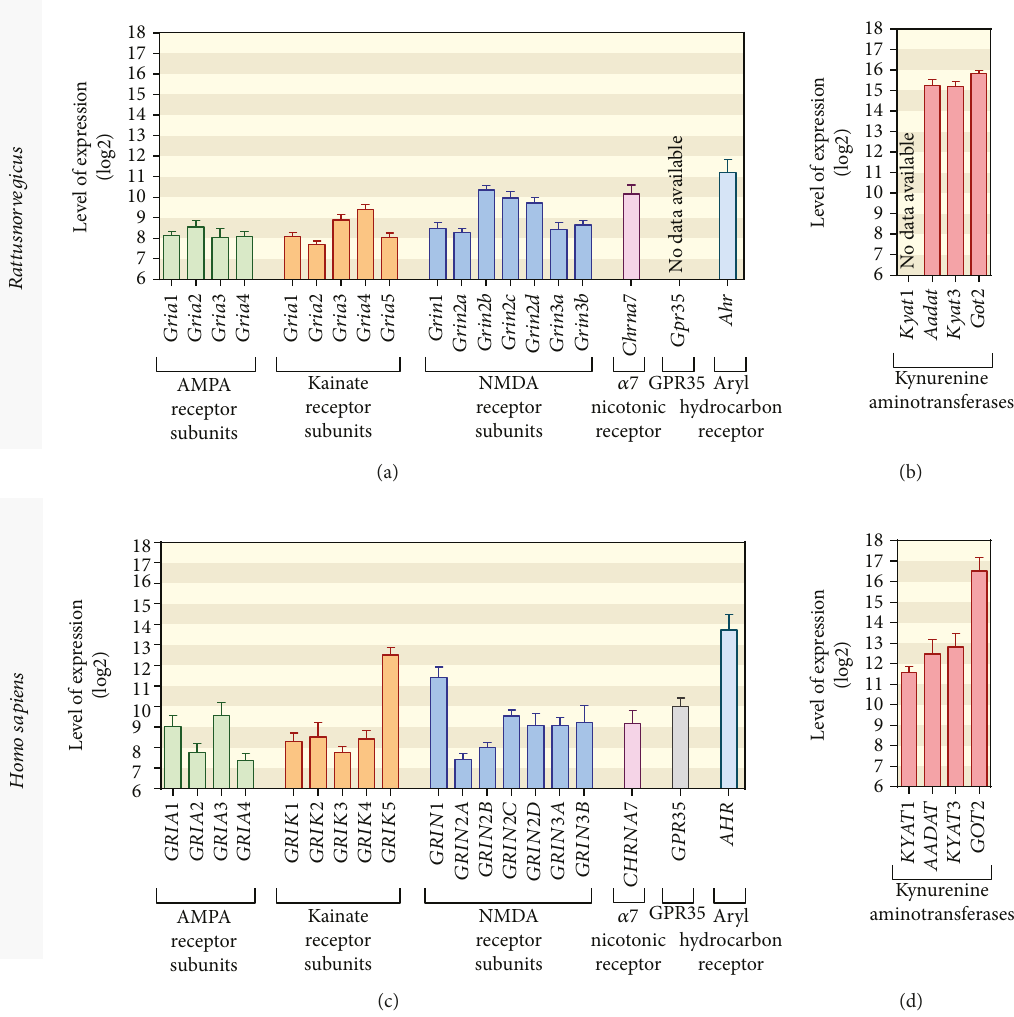
Figure 2: Expression of KYNA-related genes in rat and human liver tissue. (a) Expression of genes coding for α -amino-3-hydroxy-5- methyl-4-isoxazolepropionic acid (AMPA) receptor subunits ( Gria1 , Gria2 , Gria3 , and Gria4 ), kainate receptor subunits ( Grik1 , Grik2 , Grik3 , Grik4 , and Grik5 ), N-methyl-D-aspartate (NMDA) receptor subunits ( Grin1 , Grin2a , Grin2b , Grin2c , Grin2d , Grin3a , and Grin3b ), α 7 nicotinic acetylcholine receptor ( Chrna7 ), and aryl hydrocarbon receptor ( Ahr ) in rat liver tissue ( n = 3502 ). There was no available data on G protein-coupled receptor 35 ( Gpr35 ) expression. (b) Expression of Aadat , Kyat3 , and Got2 genes coding for kynurenine aminotransferases (KATs) in rat liver tissue ( n = 3502 ). No probes were available for Kyat1 gene within the selected array. Data on rat gene expression were retrieved from previously described [26 – 37] microarray experiments deposited in GEO (accession numbers: GSE5350, GSE5509, GSE8880, GSE10408, GSE11097, GSE11097, GSE10411, GSE10015, GSE12196, GSE14712, GSE57822, GSE73500) and ArrayExpress (accession numbers: E-MTAB-799, E-MTAB-800) databases. (c) Expression pro fi le of human orthologues of the rat genes coding for KYNA-related receptors ( n = 70 ). (d) Expression of human orthologues of KAT- coding rat genes ( n = 70 ). Data on expression of the genes of interest in human liver tissues were extracted from previously described [38 – 44] microarray-pro fi ling experiments available at the GEO repository (accession numbers: GSE23343, GSE11190, GSE3526, GSE37031, GSE55092, GSE28619, GSE7307,